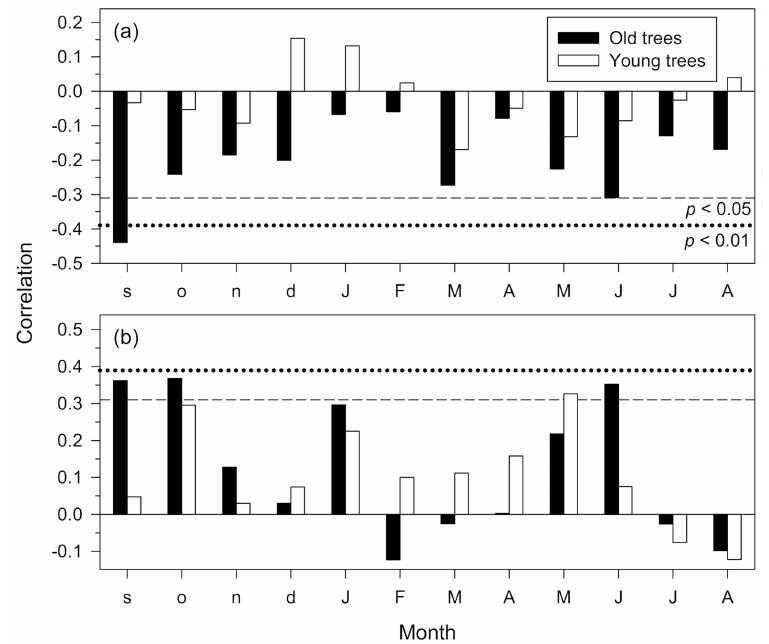
Figure 3. Correlations calculated between the chronologies of old and young trees and ( a ) mean monthly temperatures or ( b ) monthly precipitation. Horizontal dashed and dotted lines show the 0.05 and 0.01 significance levels, respectively. The prior- and current-year months were abbreviated using lowercase and uppercase letters,